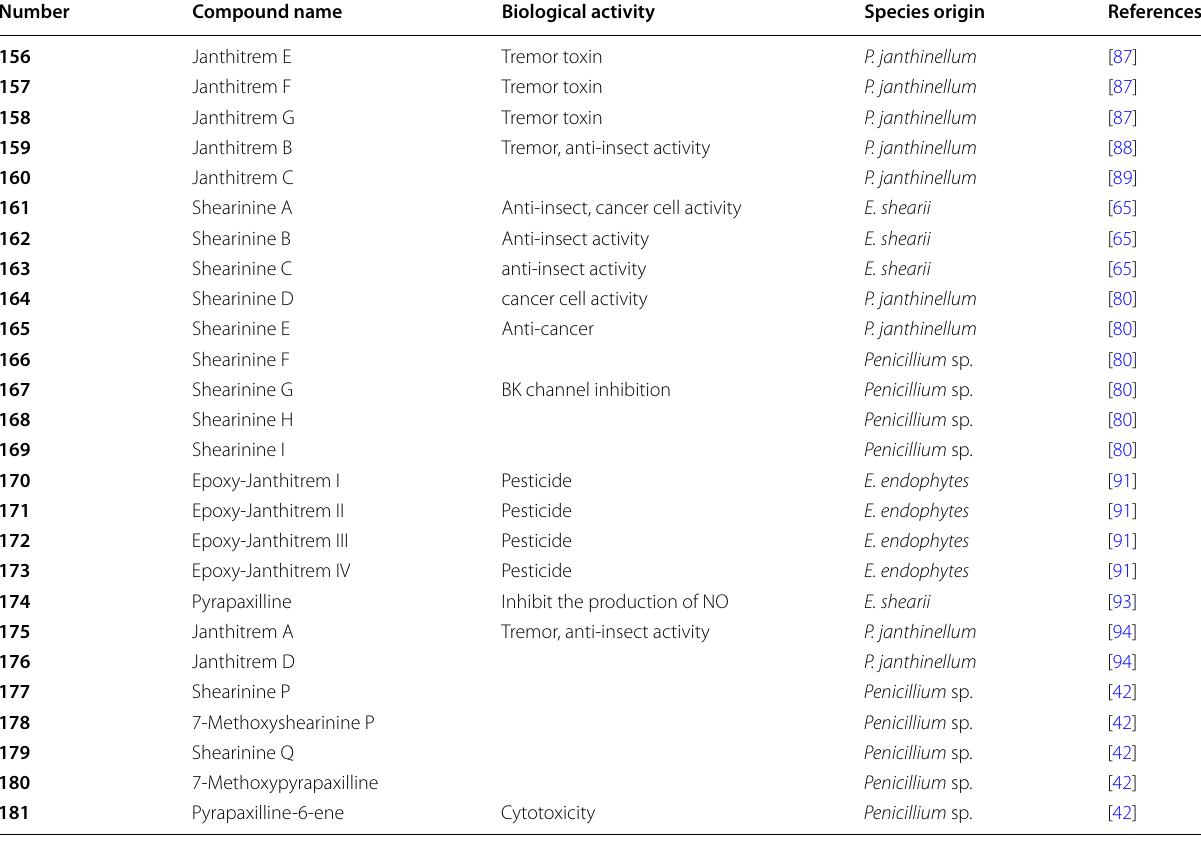
Table 11 Name, bioactivities and source of compounds with A‑ring 6/5 member ring